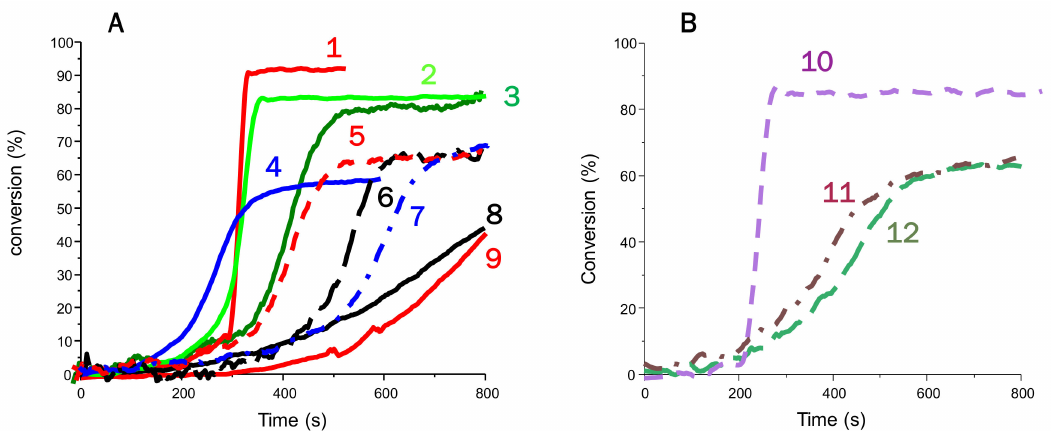
Figure 9. Real Time Fourier Transform Infrared (RT-FTIR) photopolymerization kinetics (C = C conversion vs. irradiation time; 1.4 mm thick sample) under air upon exposure to a Laser